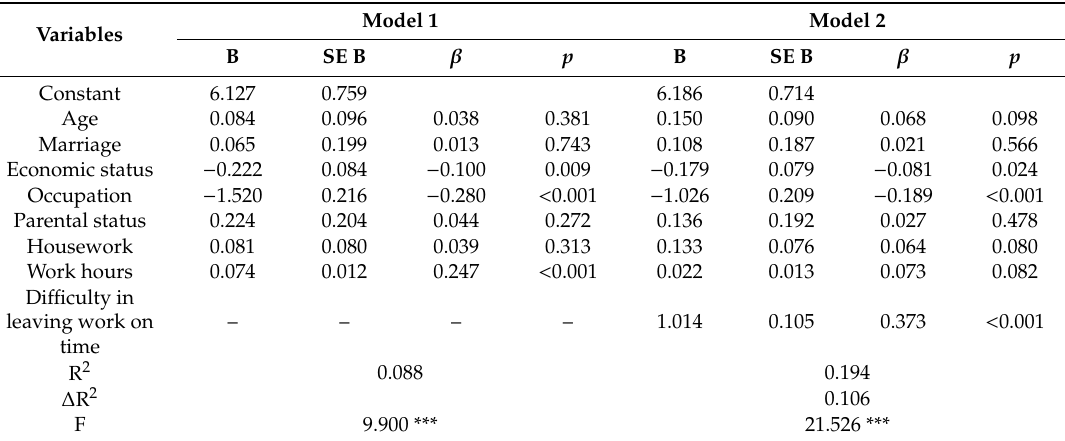
Table 3. Multiple regression for